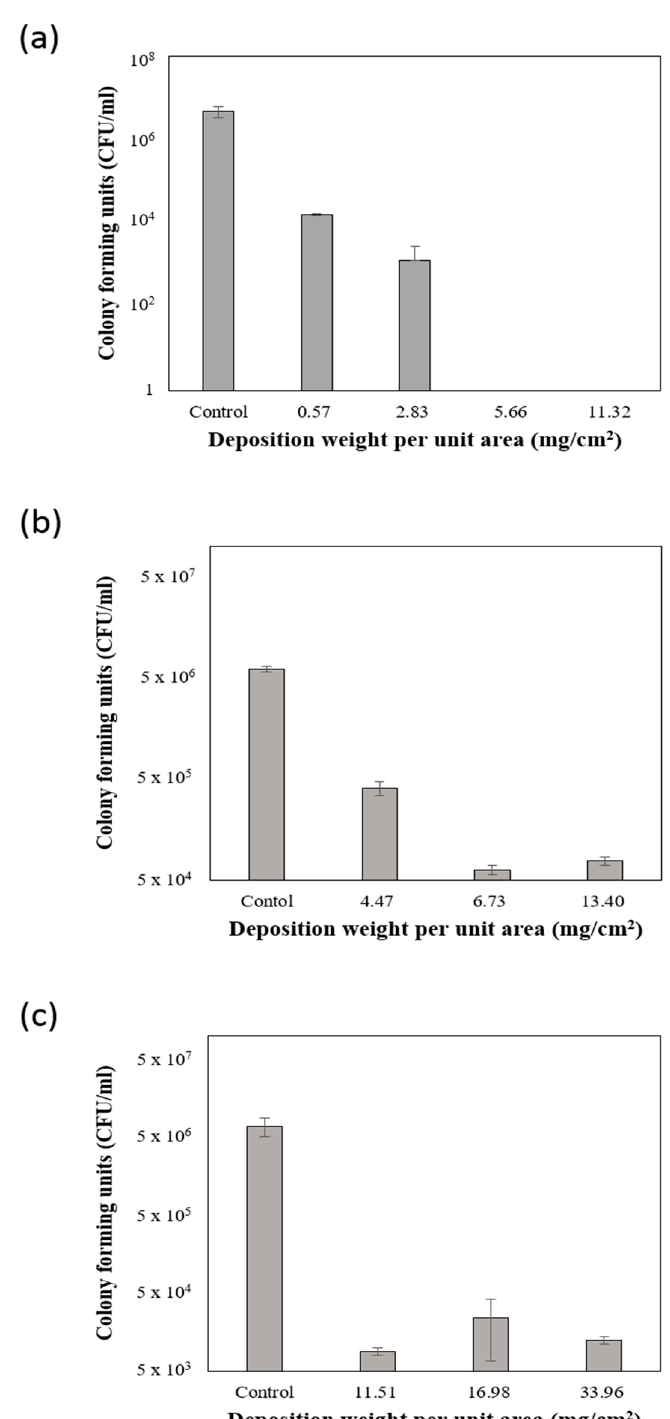
Figure 3. M. luteus colony-forming units 48 h after bioaerosol exposure vs. weight of plant extract per unit area. ( a ) tea-tree oil, ( b ) rosemary, and ( c ) garlic.